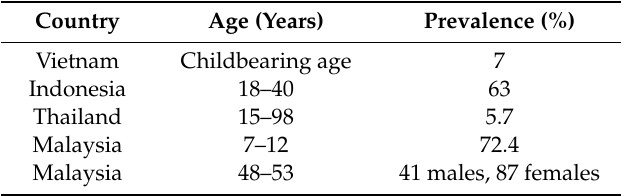
Table 5. Prevalence of Vitamin D deficiency (25-OH-D3 < 50 nmol / L) in Southeast Asia. Country Age (Years) Prevalence (%) Vietnam Childbearing age 7 Indonesia 18–40 63 Thailand 15–98 5.7 Malaysia 7–12 72.4 Malaysia 48–53 41 males, 87 females Source: Modified from Yang et al.